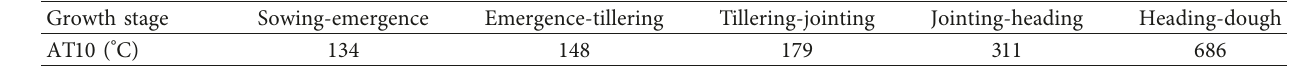
Table 2: AT10 thresholds of winter wheat at different growth stages.